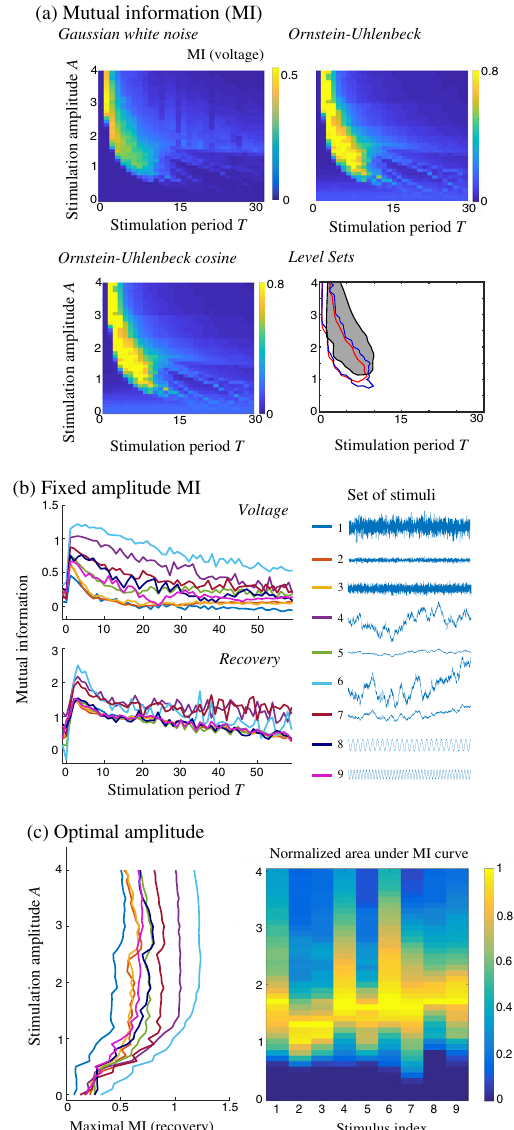
FIG. 11. Mutual information estimation for the Fitzhugh- Nagumo network model, parameters and setting as in Fig. 7. (a) Mutual information (recovery variable) as a func- tion of the amplitude and period of the periodic stimulation for Gaussian white noise, Ornstein-Uhlenbeck, or Ornstein- Uhlenbeck centered at a sine wave. Lower right-hand panel: Peak of mutual information (identified through a level set in the map) coincides with the disappearance of oscillations (gray region, as in Fig. 7). (b) Mutual information as a function of the period of the periodic stimulus (amplitude A ¼ 2 ) for 9 sample stimuli high- lighting the coincidence of their maxima, both for voltage and recovery variables. (c) The amplitude and width of the peak vary with input amplitude. Left: Maximal value of the mutual infor- mation found for each stimulation amplitude: (Right) An optimal amplitude stands out when considering the area under the mutual information curve[normalized bythelargestareaforeachstimulus type highlighted in (b)], suggesting the existence of an optimal stimulation